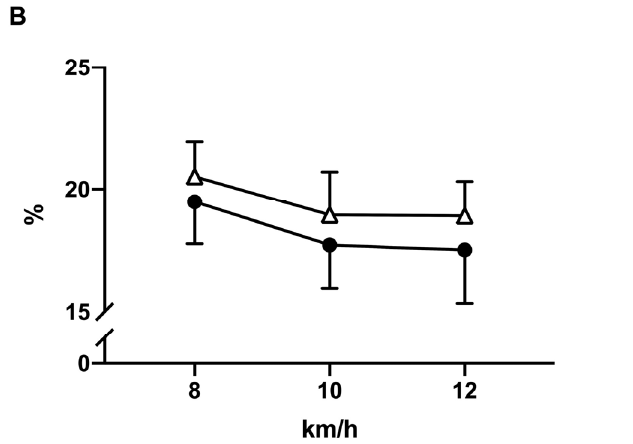
Figure 2. The coefficients of variation of peaks amplitude ( A ) and peaks width ( B ) for FC and URV conditions.